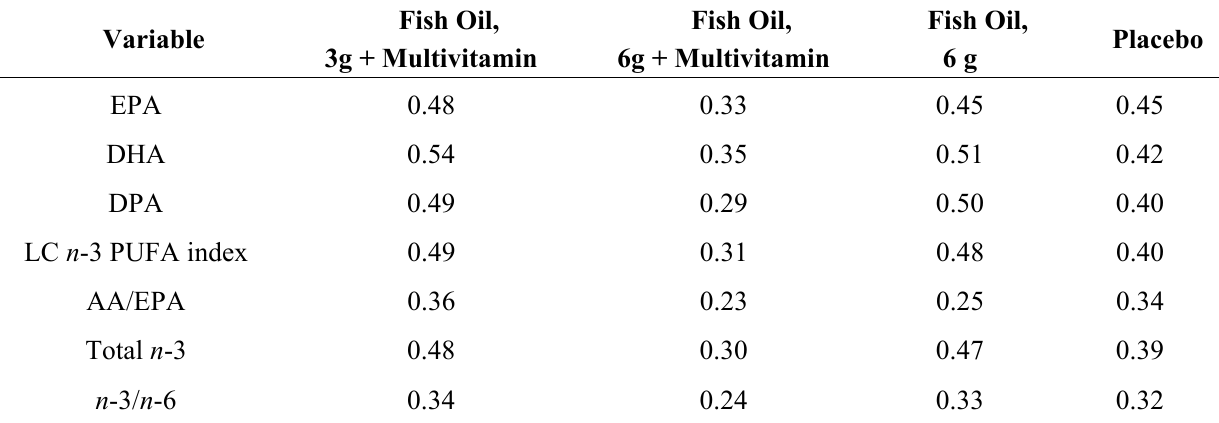
Table 3. Coefficients of variation for each n -3 fatty acid blood measure at week 16, stratified by treatment allocation.